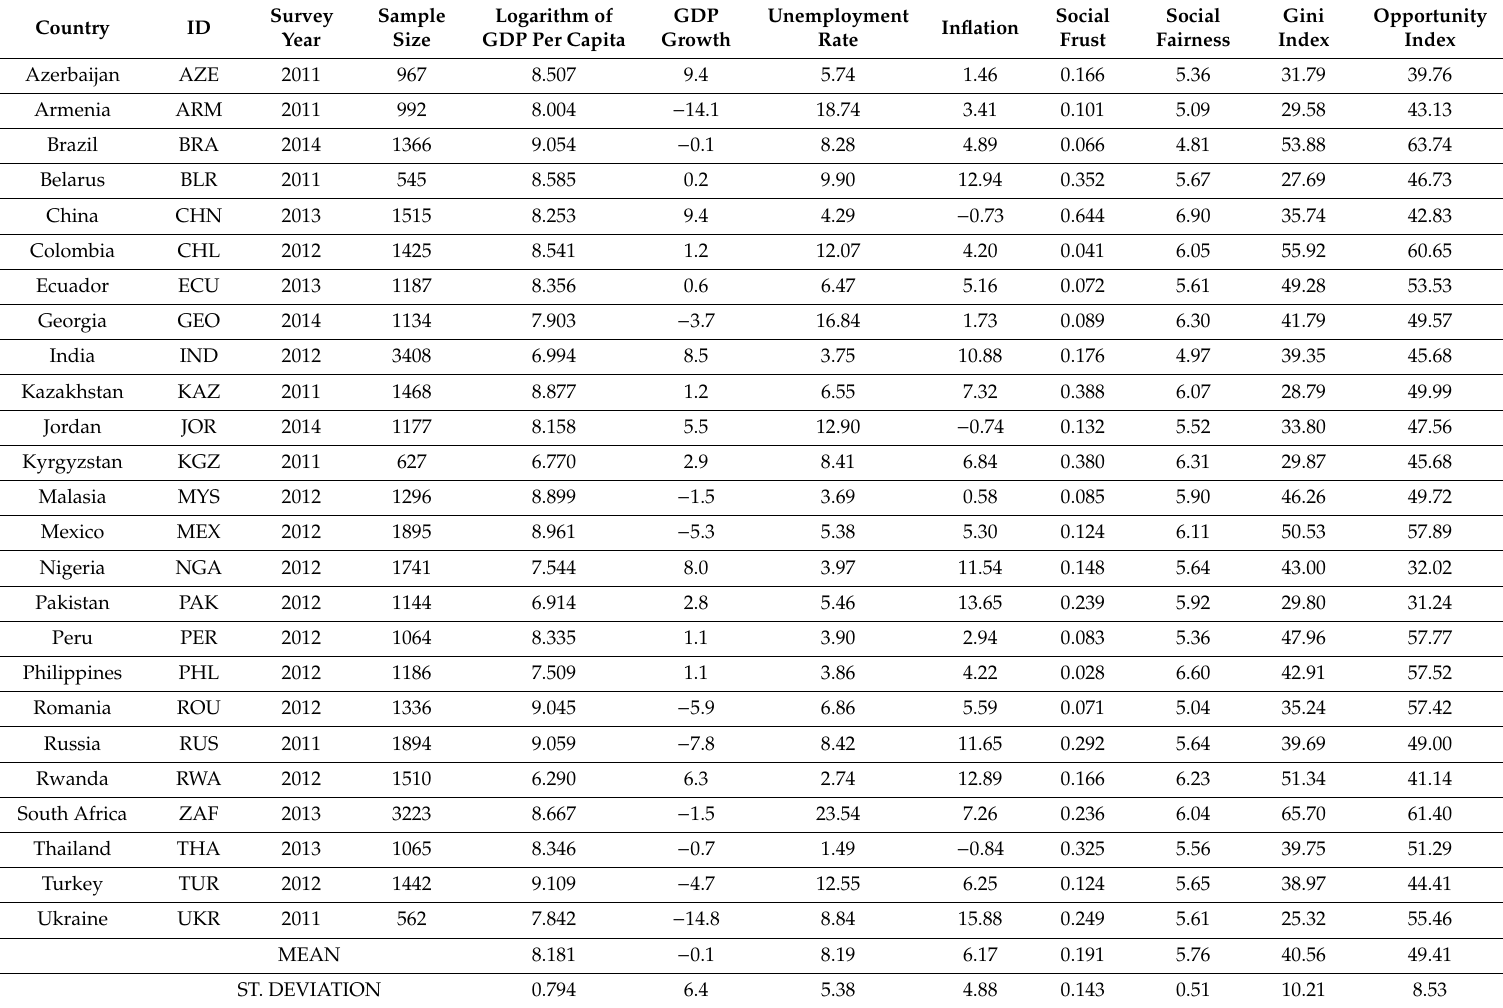
Table A2. List of countries and their macroeconomic